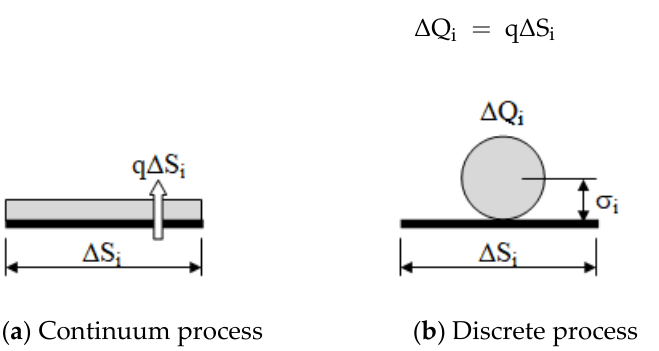
Figure 2. Shedding of a nascent temperature particle from a flat panel.